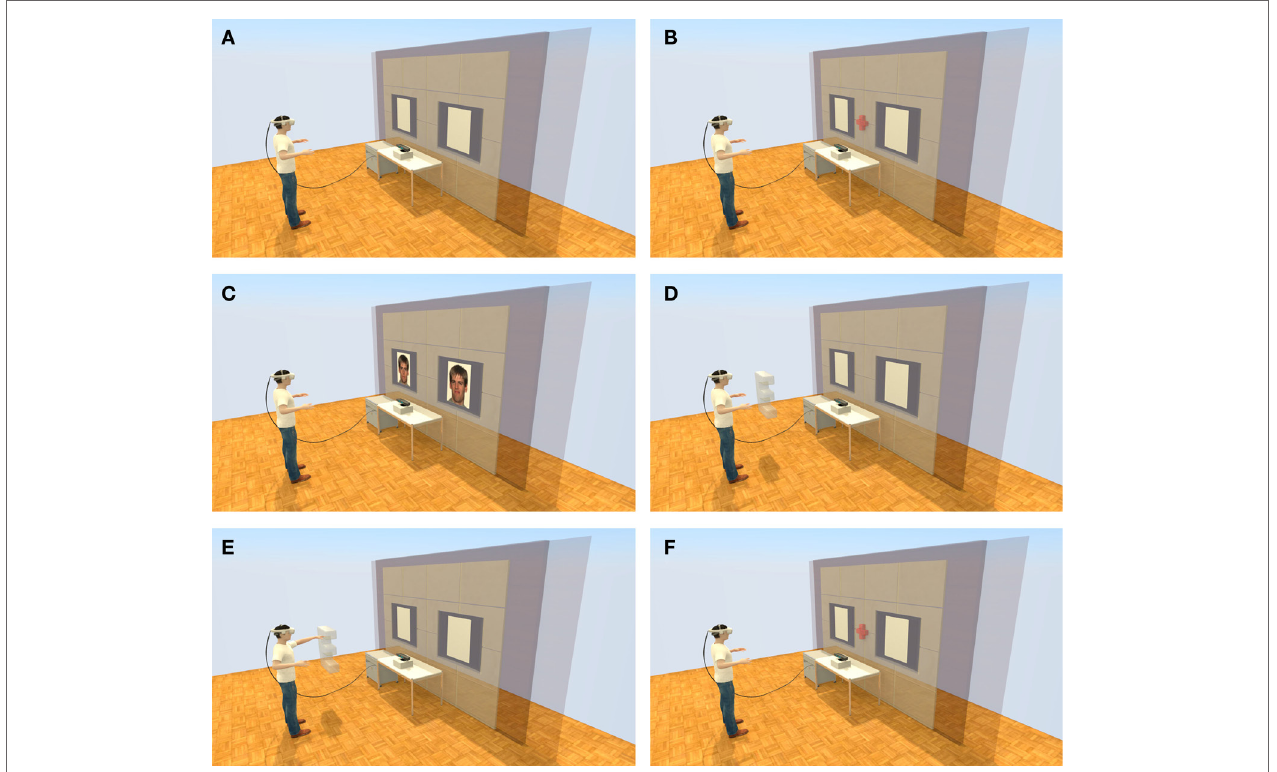
FiGUre 1 | schematic of the vr setup . The semitransparent part (i.e., the wall with the two blank picture frames) of the image represents the VE the participants viewed. (A) A Microsoft Kinect was used as a whole body-tracking device; (B) Illustration of the red fixation cross, which disappeared after 500 ms; (c) 500 ms presentation of the two face stimuli (e.g., neutral and disgust expression); (D) Virtual 3D letter appeared in front of the neutral face; (e) The participant hit the virtual letter on the left side with his left arm; and (F) End of trial, next trail begins with the red fixation cross